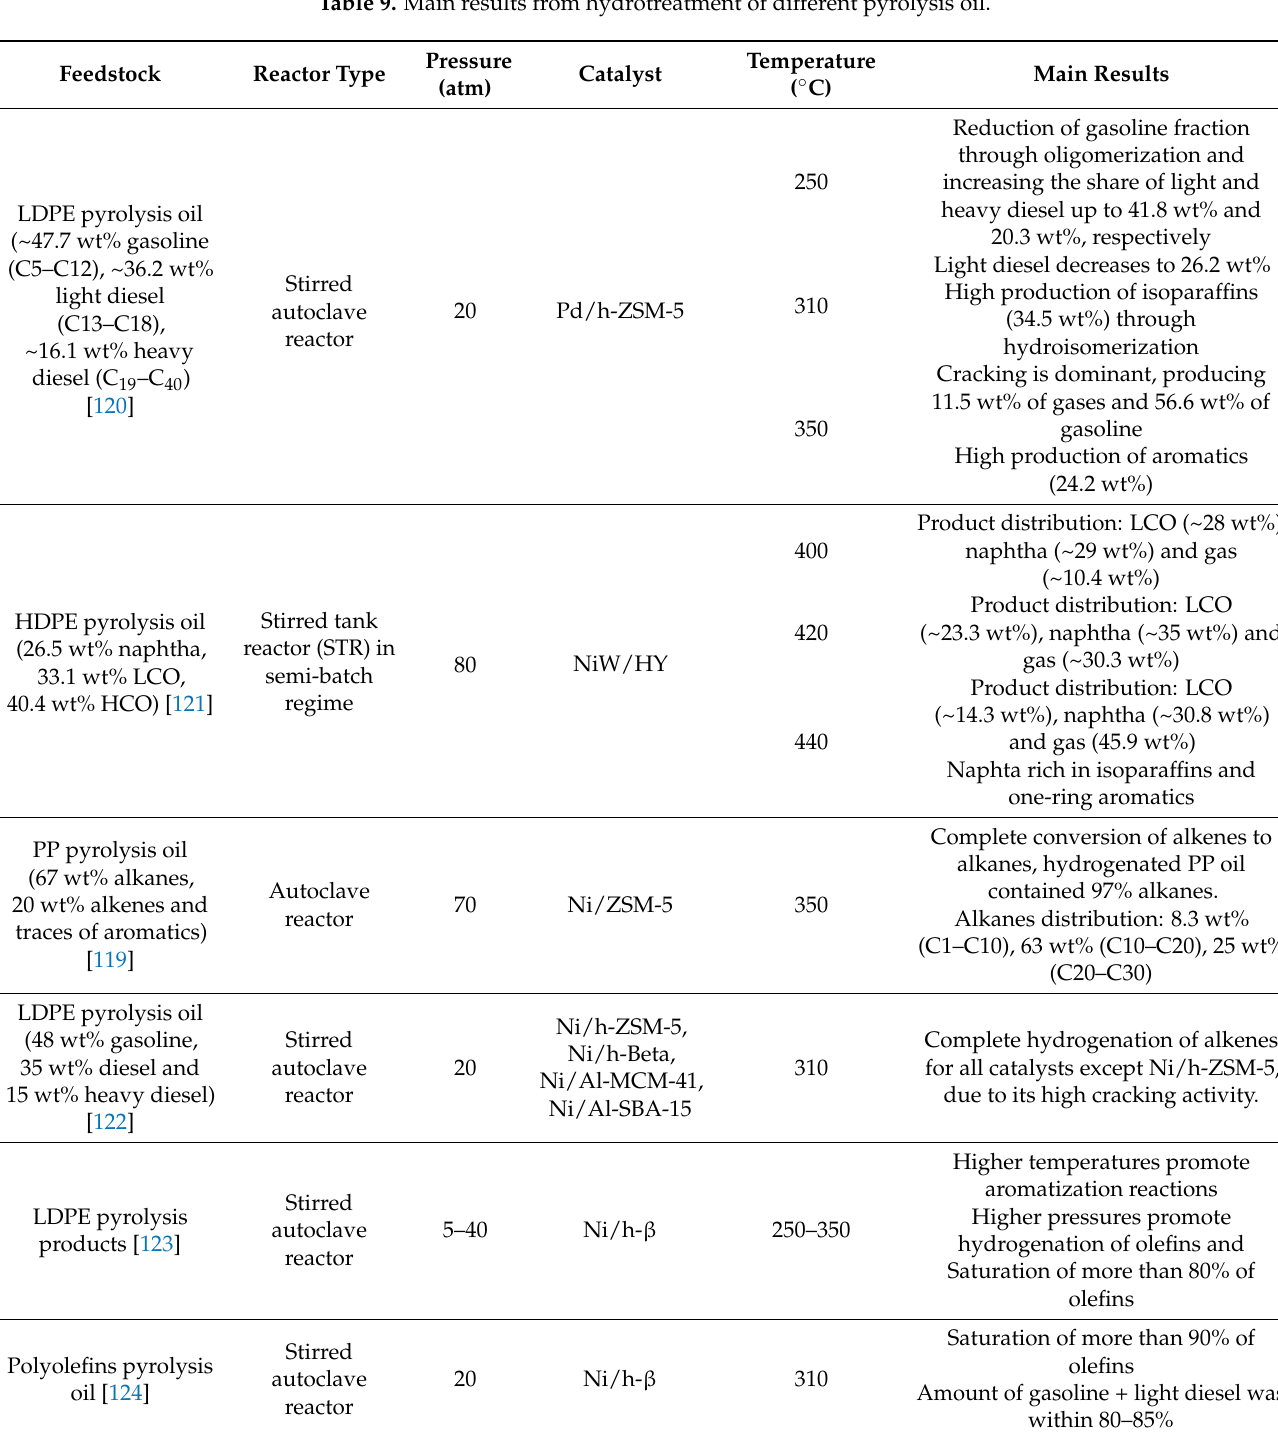
Table 9. Main results from hydrotreatment of different pyrolysis